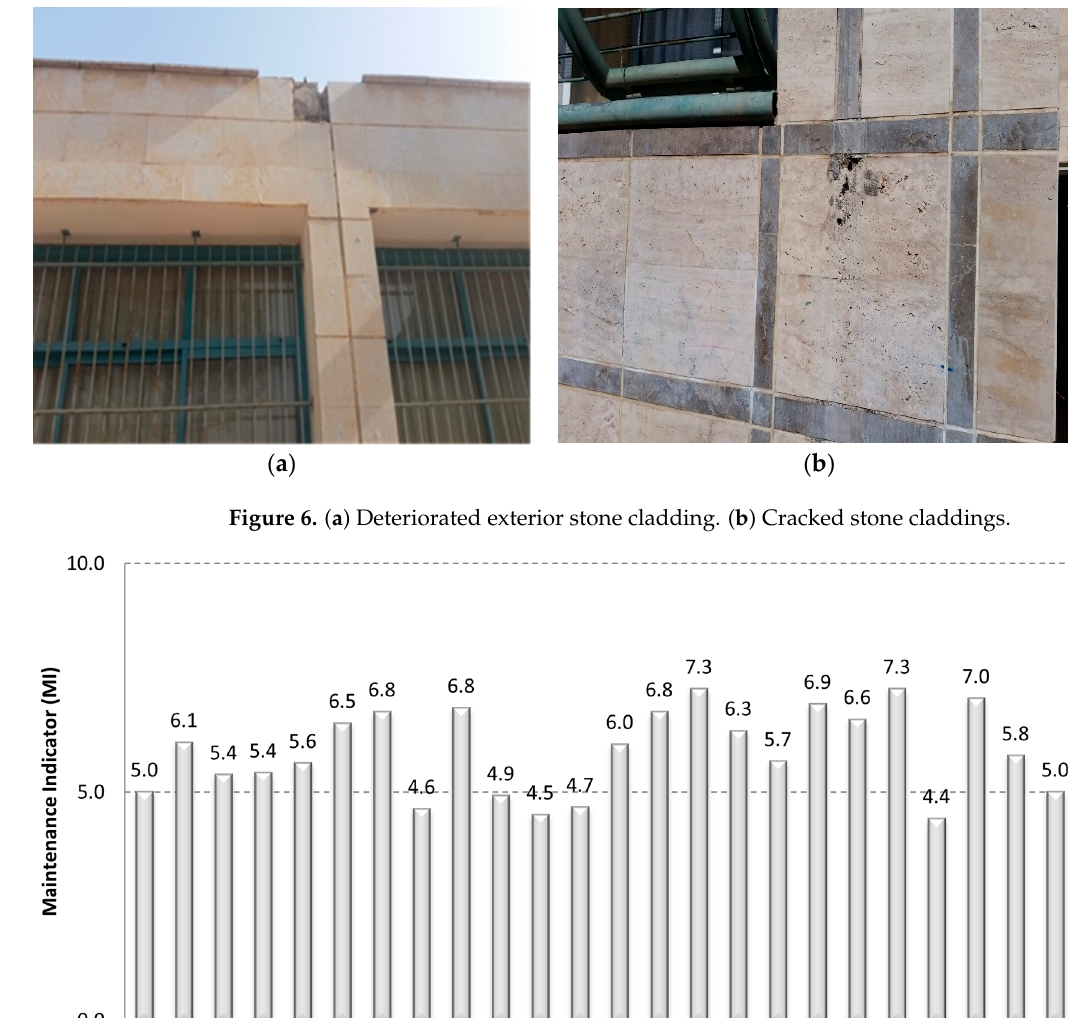
Figure 5. Sports—( a ) unprotected basket column and ( b ) poorly maintained basketball surface.